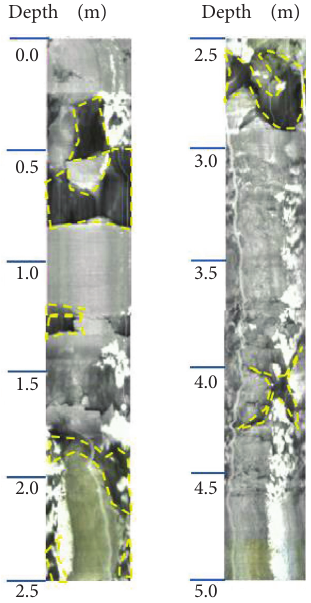
Figure 7: TV imaging in the inspection